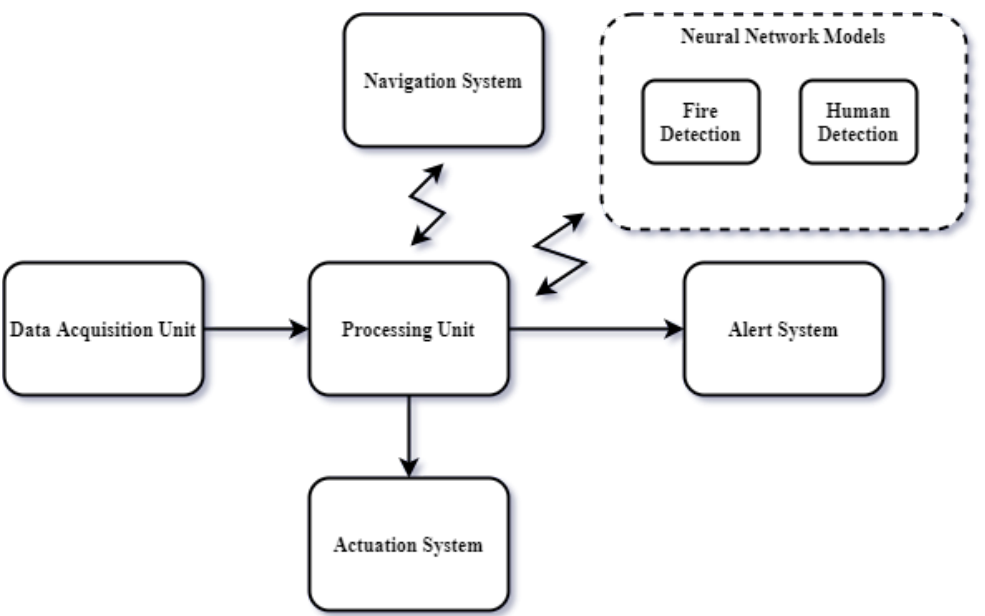
Figure 1. Overall functional block diagram of learning-based automated fire extinguishing system.